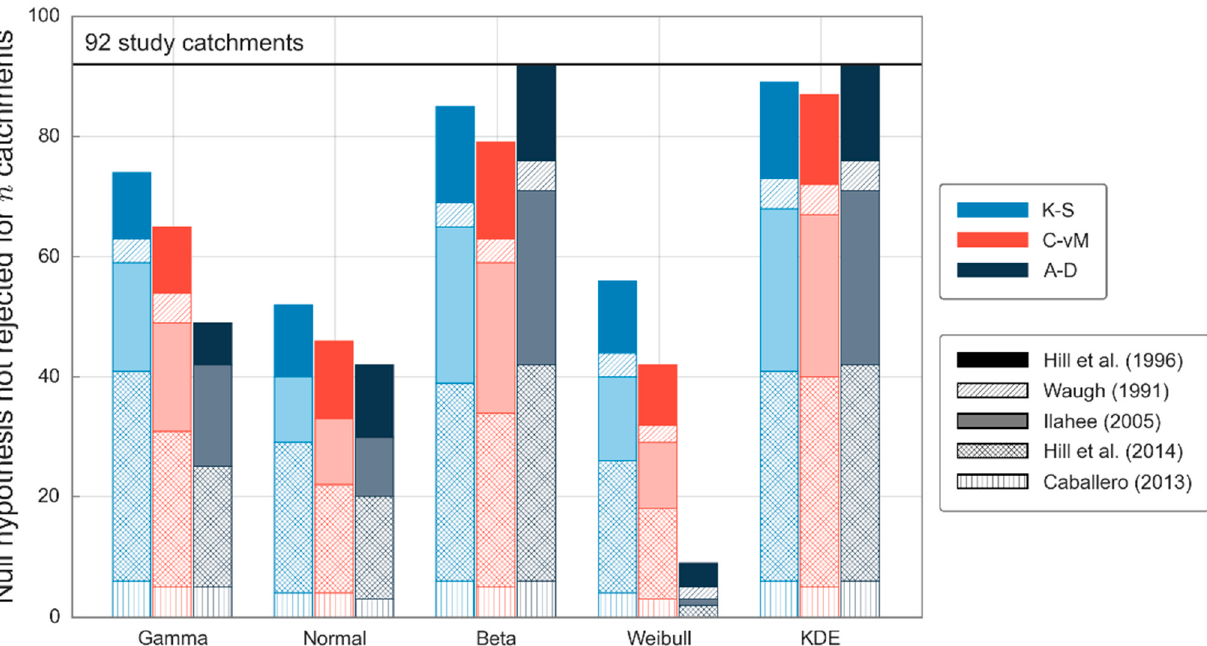
Figure 2. Number of catchments in which the null hypothesis is rejected by each goodness-of-fit test, for each study da- taset.